Question: Which kind of chart has been used to present this data?
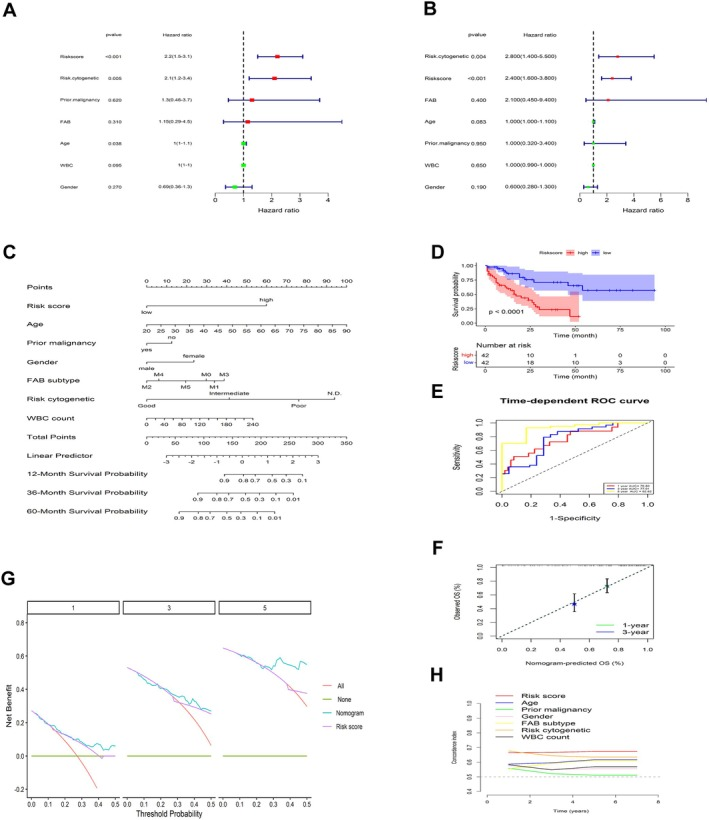
Answer: survival